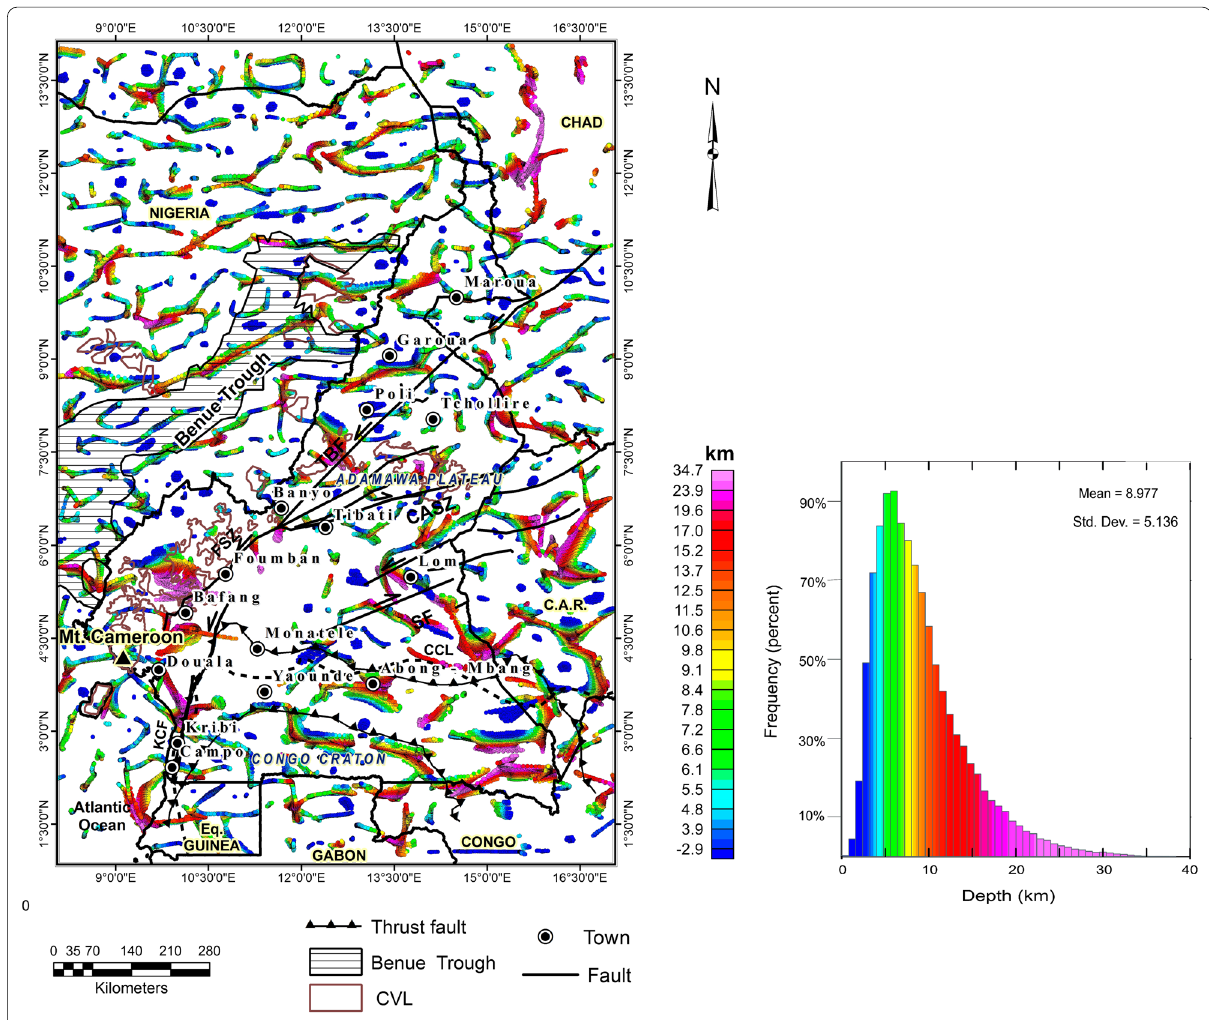
Fig. 11 Euler deconvolution for the Earth Magnetic Anomaly Grid with a structural index of